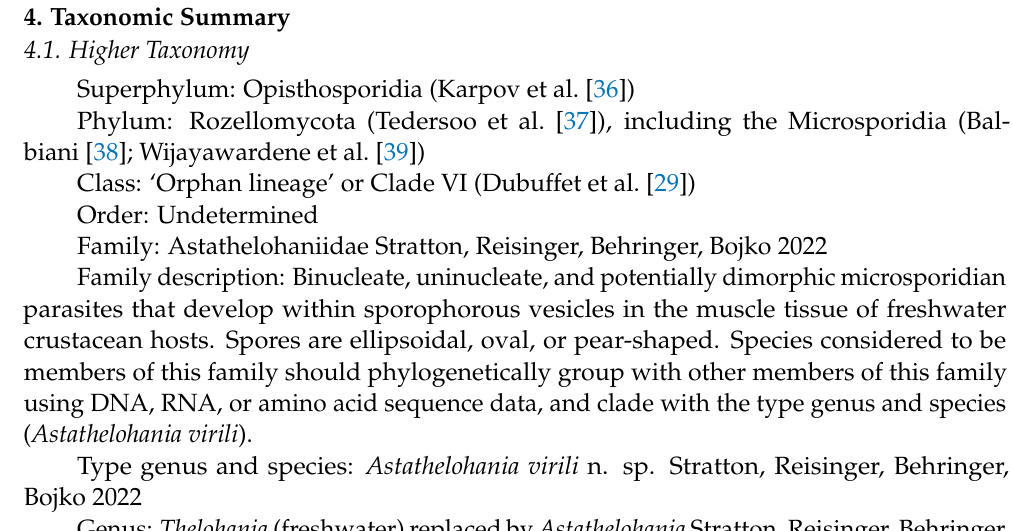
Figure 7. Representative phylogenetic-inferred cladograms of native crayfish species (“Crayfish”) from the families Cambaridae (native geography: North America), Astacidae (native geography: Europe and North America), Cambaroididae (native geography: China and Japan), and Parastaci- dae (native geography: South America, Madagascar, Australia, New Zealand), compared with microsporidian isolates from the freshwater Thelohania (now revised to Astathelohania ) (“Parasites”). The accession numbers for the isolates are listed by the name of the species on each tree. The microsporidian cladogram was developed from the tree presented in Figure 6. For the “Crayfish” tree, cytochrome oxidase 1 DNA sequence data were aligned using MAFFT and constructed using IQtree [34]. The trees were drawn and annotated in FigTree